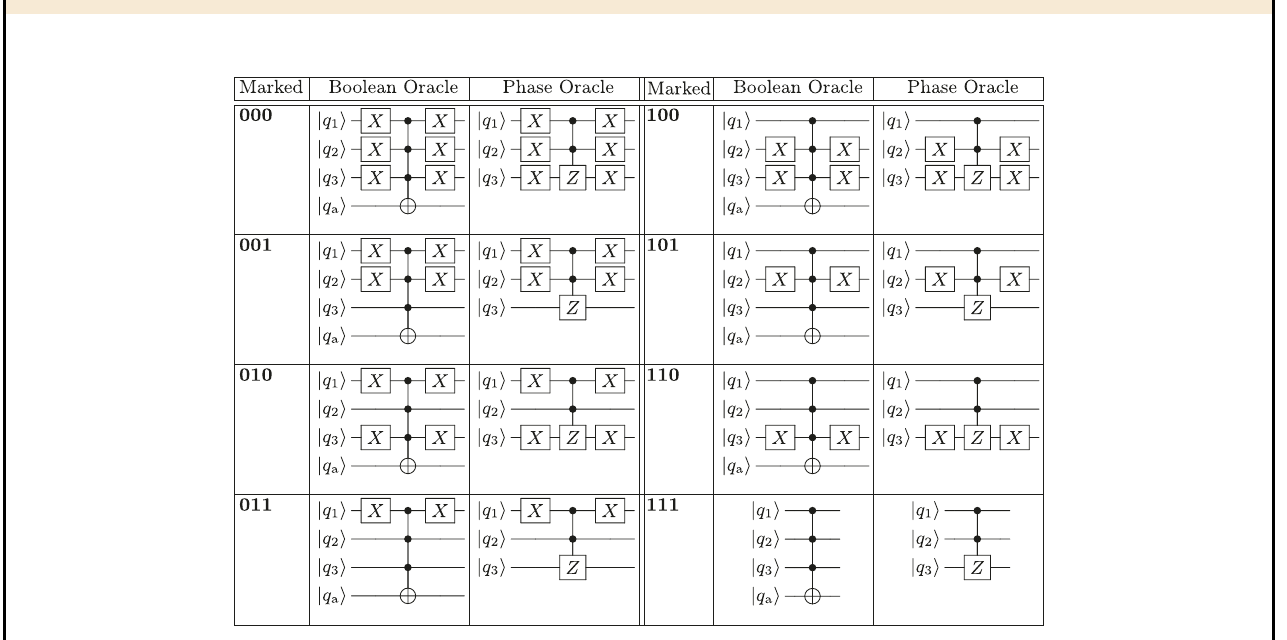
Table of all oracles used for the single-solution Grover search